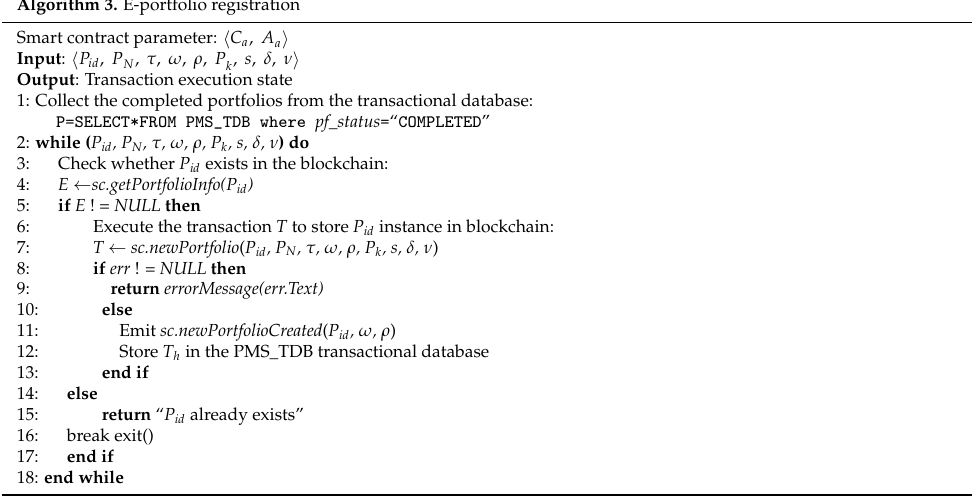
Algorithm 3. E-portfolio registration